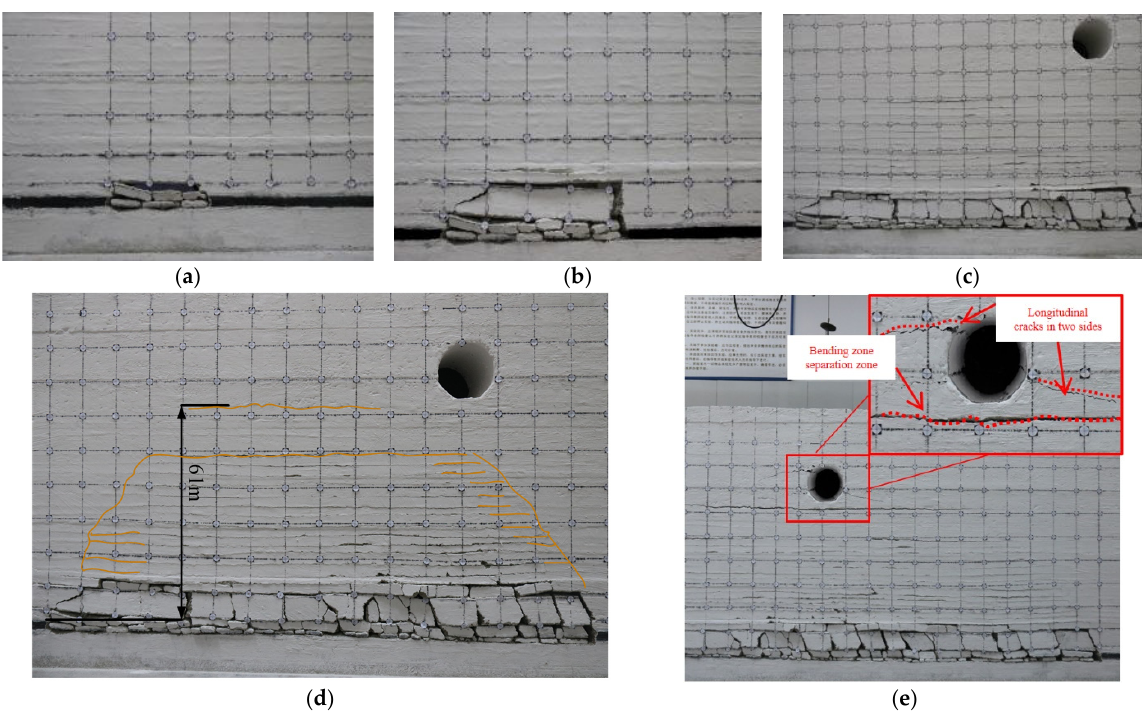
Figure 5. Map of fracture and fracture development under mining disturbance. ( a ) Advancing distance 24 m; ( b ) Advancing distance 43 m; ( c ) Advancing distance 138 m; ( d ) Advancing distance 156 m; ( e ) Advancing distance 240